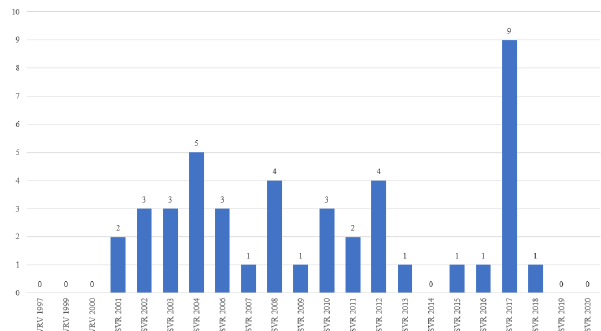
Figure 11. Overall distribution of papers from the “3D Interaction”